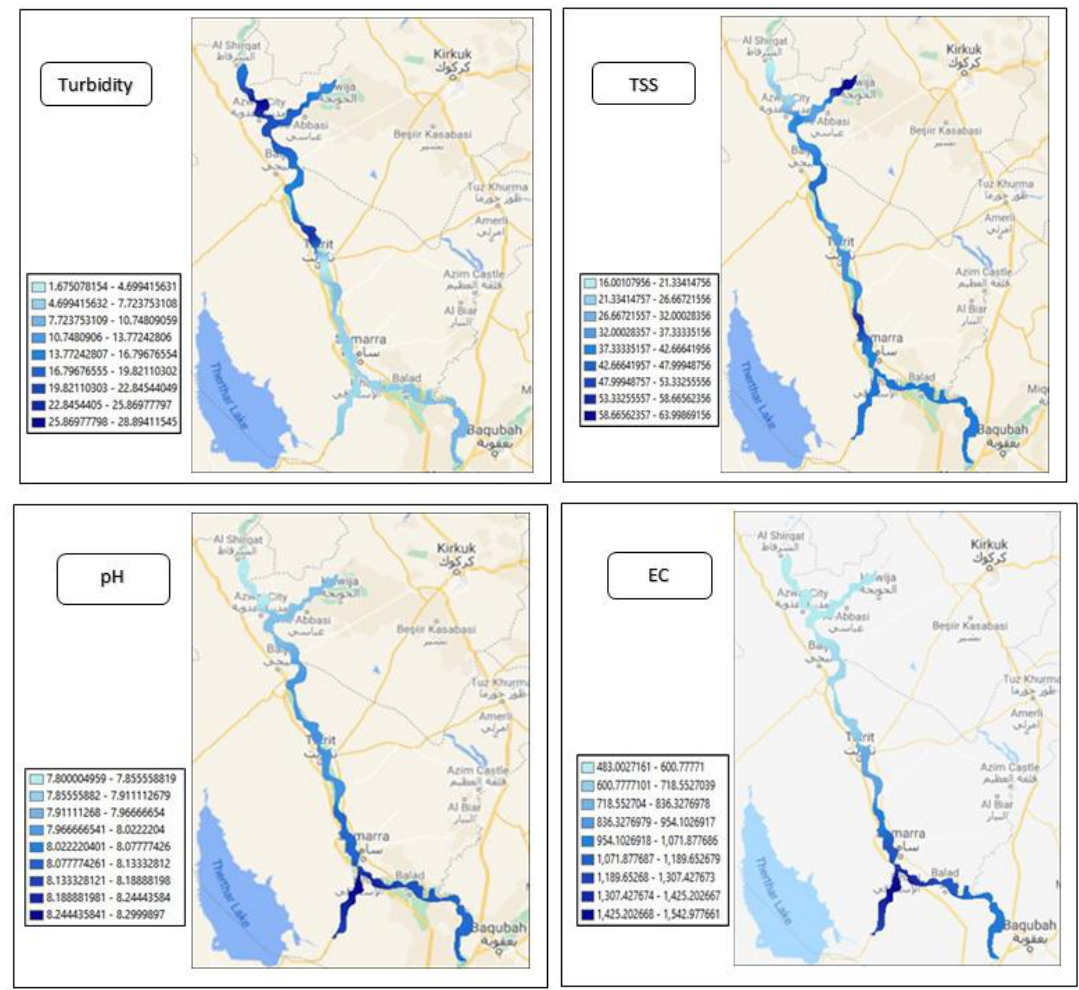
Fig.4: Spatial maps of concentration distribution for Turbidity, T.S.S., PH and